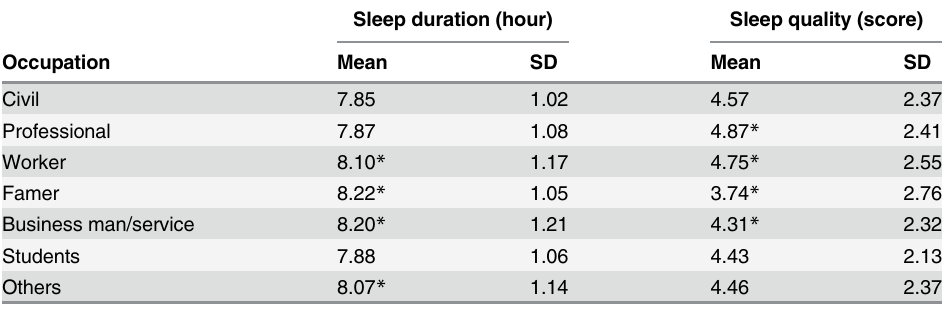
Table 2. Distribution of sleep duration sleep quality scores by occupation.